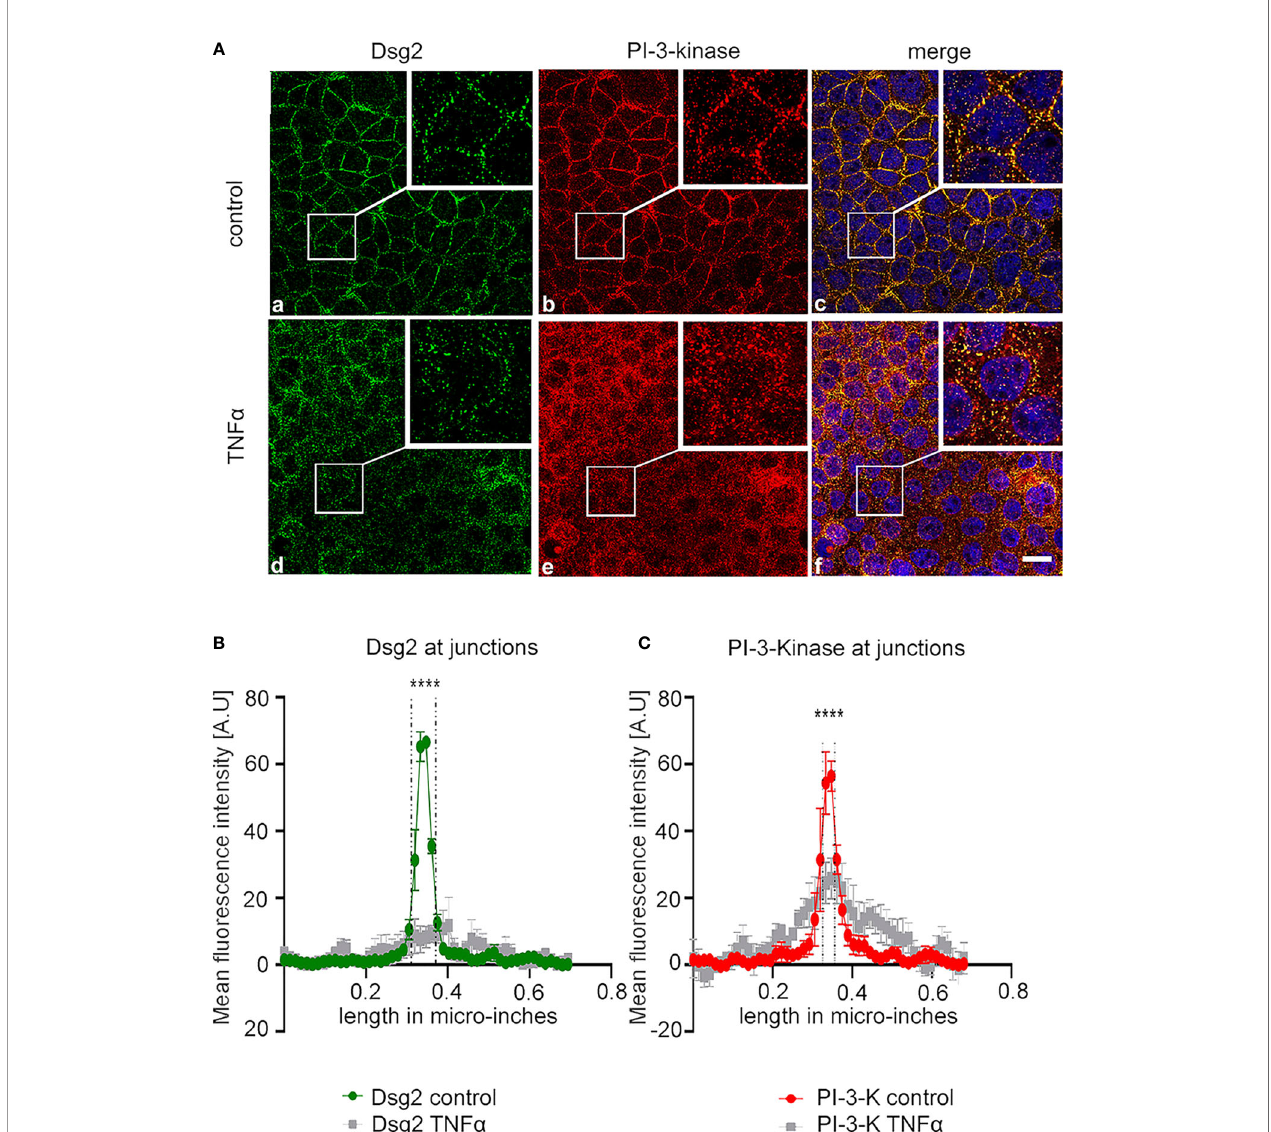
FIGURE 7 | Dsg2 sequesters PI3-kinase under basal conditions. (A) Immunostaining for Dsg2 (a,d)=and PI-3-kinase Caco2 cells under control conditions (a-c) and following treatment with TNF a for 24h at 100 ng/ml (d-f) are shown. Merge images include staining with DAPI to visualize cell nuclei (c,f). Images shown are representative for n=4 experiments, scale bar is 2 b µm. (B, C) Quanti fi cation of all experiments for the conditions of the immunostaining images shown in A are presented; dashed lines in the graphs indicate the area of cell junctions; Asteriks mark signi fi cant difference ****p < 0.00001; two way